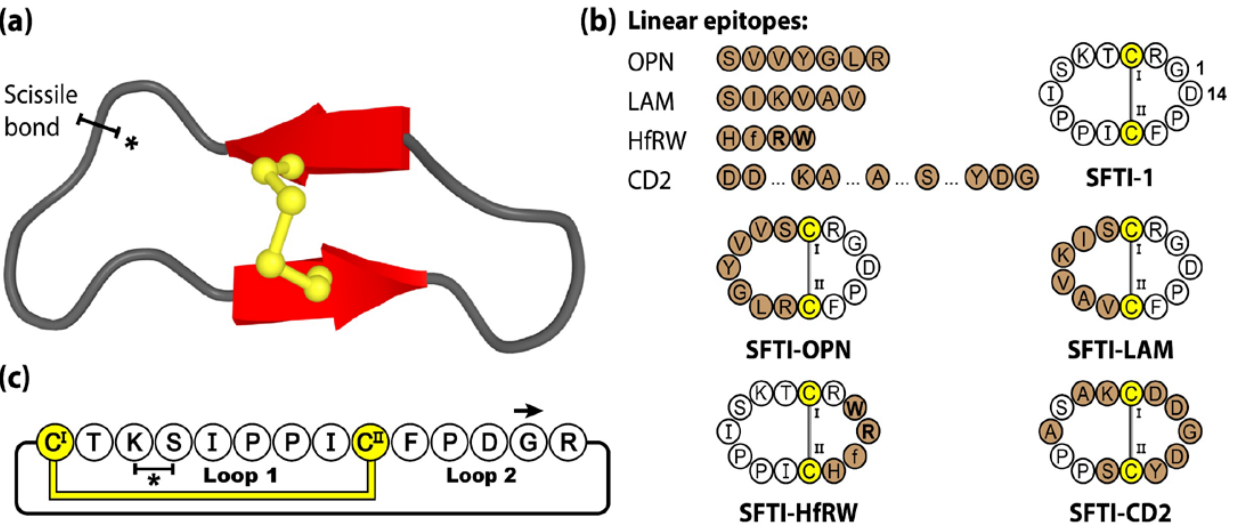
Figure 3. Structure and sequence of SFTI-1, the prototypic PDP member, and four grafted examples. ( a ) Three-dimensional structure of SFTI-1, with scissile bond signified by a * symbol. ( b ) Peptide sequences of SFTI-1 and four engineered SFTI variants. ( c ) Amino acid sequence, disulfide bond connectivity and loop nomenclature of SFTI-1. Cysteine residues are numbered and highlighted in yellow, with engineered epitope sequences represented by brown shading. D-amino acids are designated with lowercase lettering and N-methylated amino acids by bolded letters.